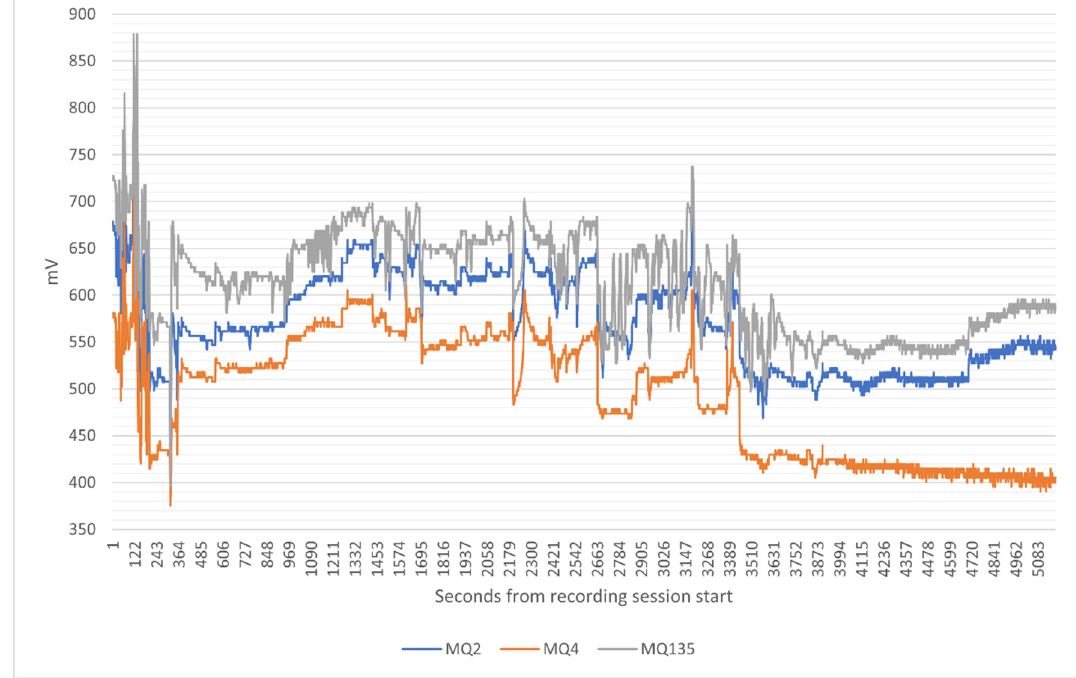
Figure 11. Graph showing the data of experimental studies conducted by the MQ2, MQ4, and MQ135 sensors in the Kariotiskes landfill site.